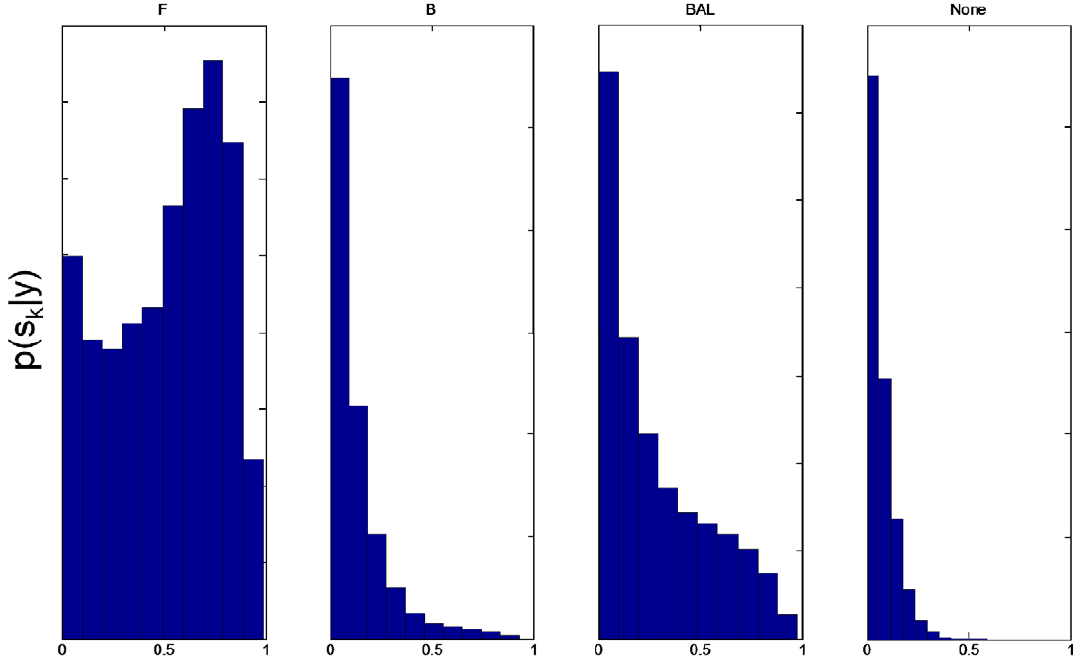
Figure 3. RFX Posterior densities for modulatory families. The histograms show p ( s k D y ) versus s k for the k ~ 1 :: 4 modulatory families. Modulatory family ‘F’ has the highest posterior expected probability v s k D Y w ~ 0 : 52 . See Table 2 for other posterior expectations.